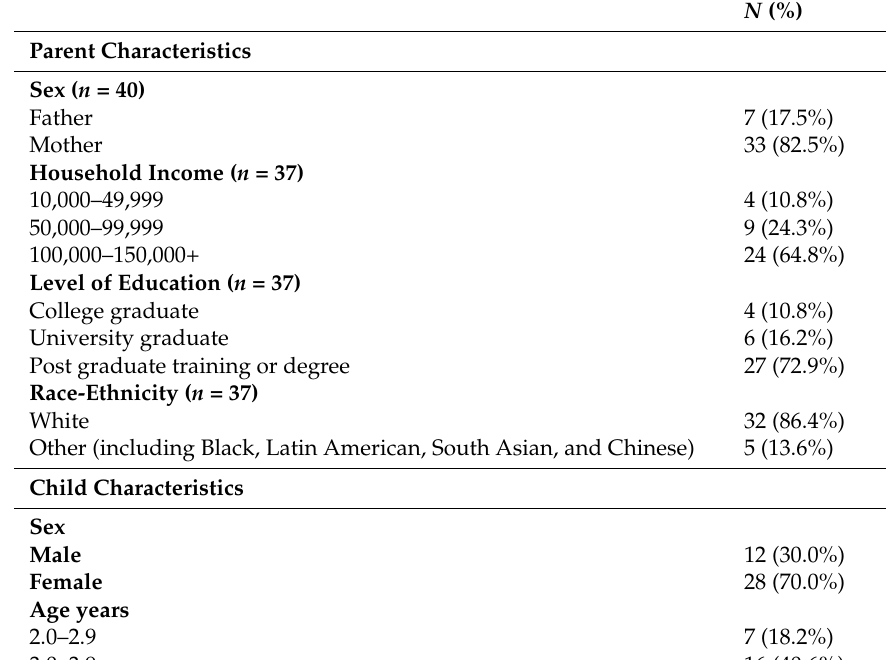
Table 1. Characteristics of the parent–child dyad participants ( n = 40) of the observation feeding study.